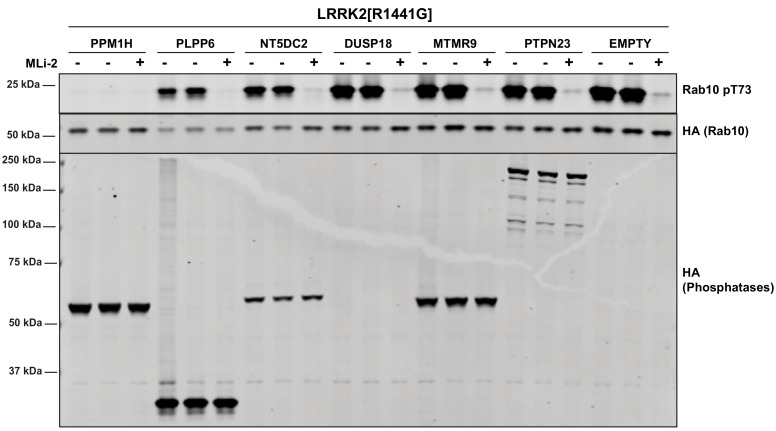
HEK293 cells were transiently transfected with the indicated constructs.24 hr post-transfection, cells were treated with ±200 nM MLi-2 for 90 min and then lysed. 10 µg of whole cell lysate were subjected to immunoblot analysis with the indicated antibodies at 1 µg/mL concentration and membranes analyzed using OdysseyClx Western Blot imaging system. Each lane represents cell extract obtained from a different dish of cells.